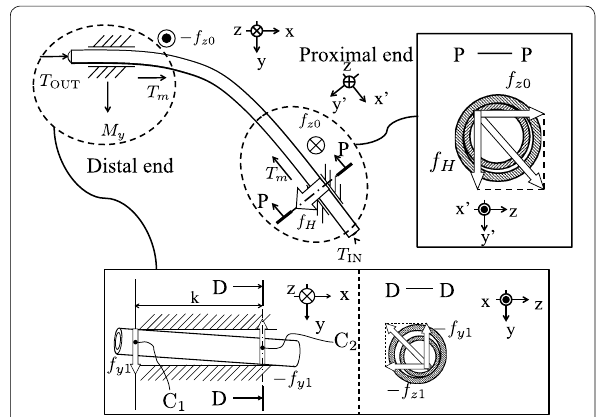
Fig. 6 Forces and torques acting on the inner C 1 and C 2 : two contact points at the distal end k : distance between C 1 and C 2 f y 1 and − f y 1 : couple of forces acting at C 1 and C 2 in the y direction f z 1 and − f z 1 : couple of forces acting at C 1 and C 2 in the z direction M y moment about the Y-axis generated by f z 1 and − f z 1 .